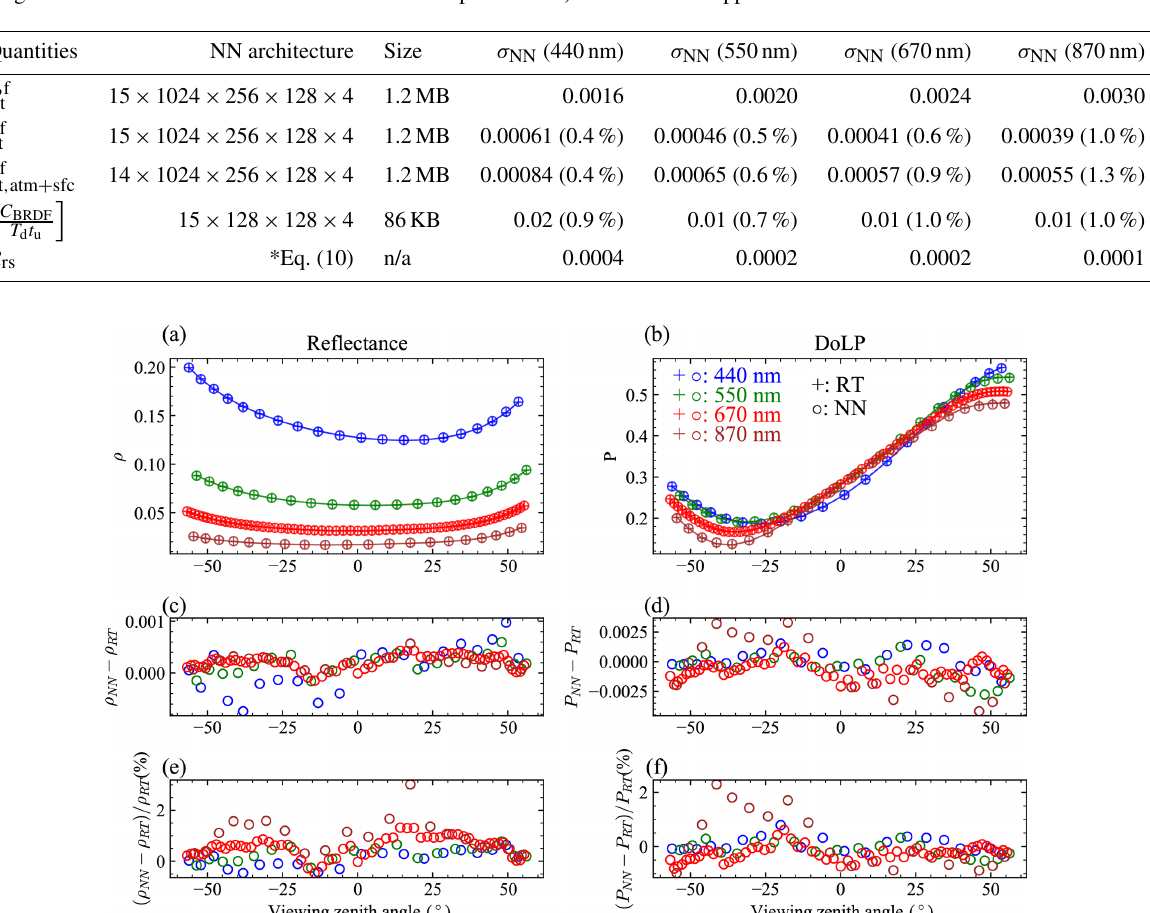
Figure 3. The synthetic HARP reflectance (a) and DoLP (b) sampled from the radiative transfer data shown in Fig. 2. Panels (c) and (d) indicate the difference between the NN predictions and RT simulations. Panels (e) and (f) indicate their percentage differences. The positive and negative signs of the viewing zenith angles indicate the azimuth angles of φ v = 116 . 2 ◦ and 180 ◦ + φ v